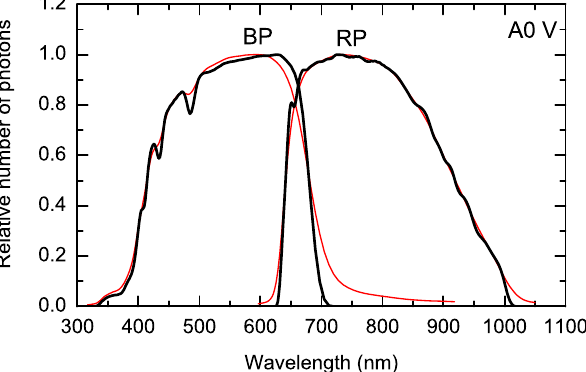
Fig. 2. The same as in Figure 1 but for A0 V type star.